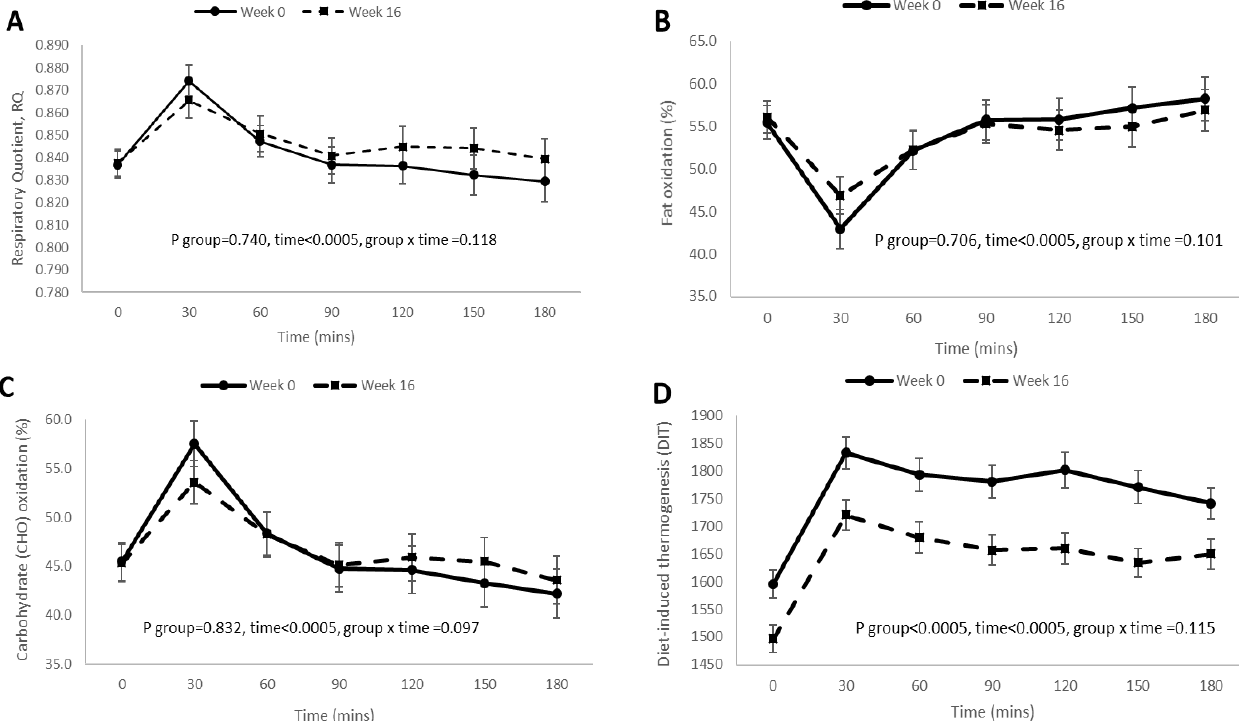
Figure 3. Postprandial RQ, fat oxidation, carbohydrate oxidation, and DIT responses after 16 weeks of weight loss intervention. ( A ) Postprandial RQ responses after 16 weeks of weight loss intervention; ( B ) postprandial fat oxidation responses after 16 weeks of weight loss intervention; ( C ) postprandial carbohydrate oxidation responses after 16 weeks of weight loss intervention; ( D ) postprandial DIT responses after 16 weeks of weight loss intervention. Data were presented as mean ± standard error at each time-point and analyzed by repeated measures ANOVA (within subject group).